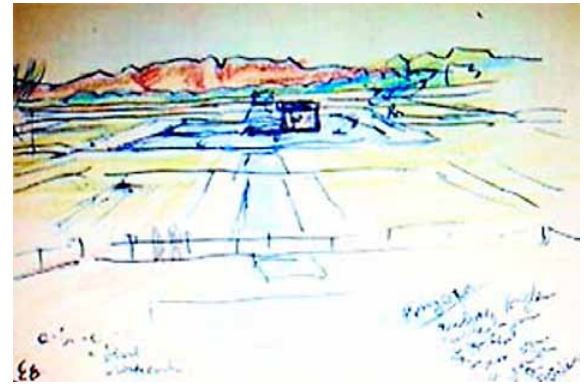
fig. 10. le Corbusier’s sketches in India (extracted from Curtis, William j. 1994)